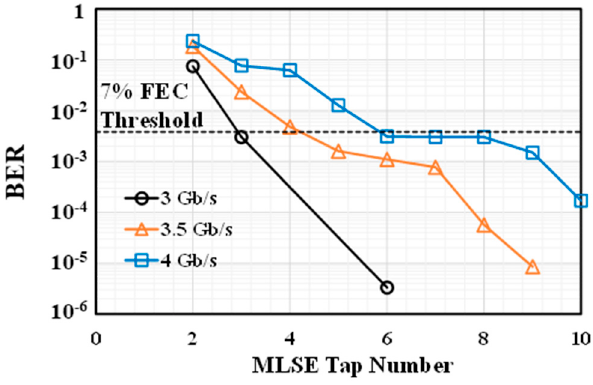
Figure 8. BER vs. signal bitrate using symbol by symbol detection and 7-tap MLSE detection.